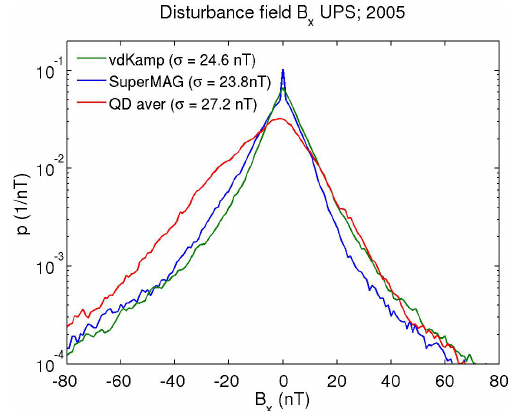
Fig. 14. Probability density function of the B x disturbance field at Uppsala over the year 2005: using the baseline from this paper (green), using the SuperMAG baseline (blue), and using as a base- line the average values of quiet days